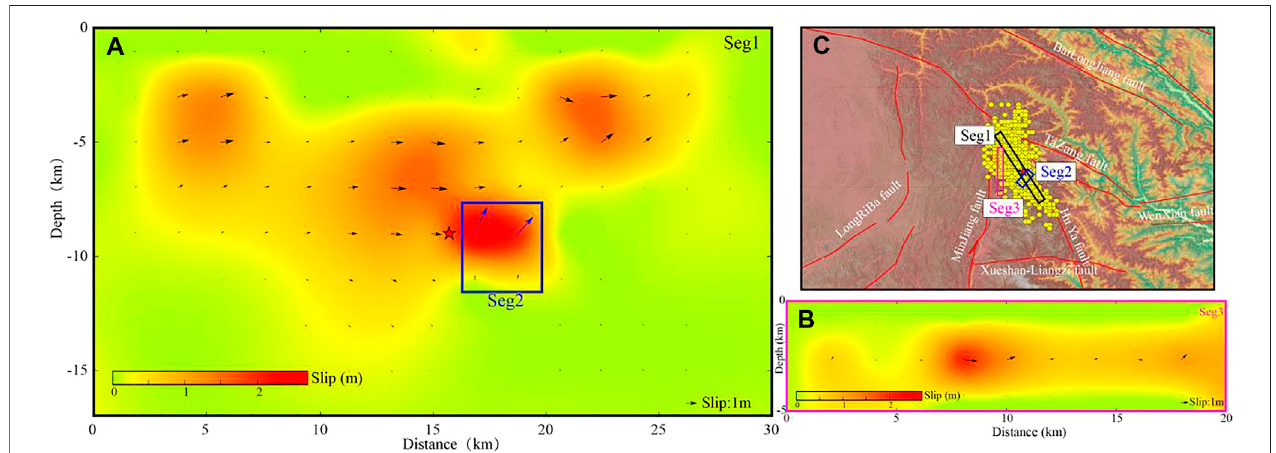
FIGURE 4 | Fault plane solution geometry and slip distribution (Sun et al., 2018). (A) Slip distribution on Segment 1 and Segment 2. Red pentagram: epicenter of JZGEQ. (B) SlipdistributiononSegment3. (C) Three fault segments areplottedinblack,blue, andpink boxes, respectively. Thedistributionofaftershockseismicitiesis plotted as yellow fi lled dots. Slip directions are plotted with arrows for every subfault,